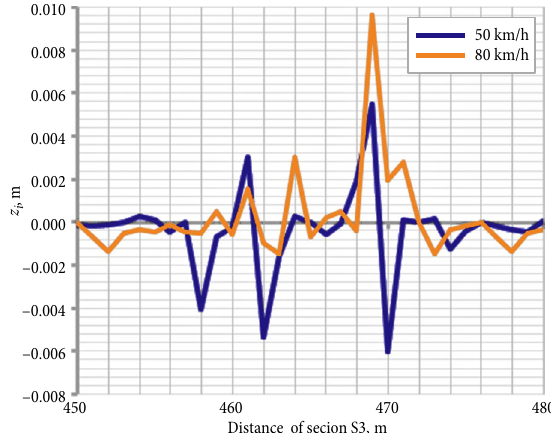
Fig. 8. Wheel motion when driving on road roughness at different speed